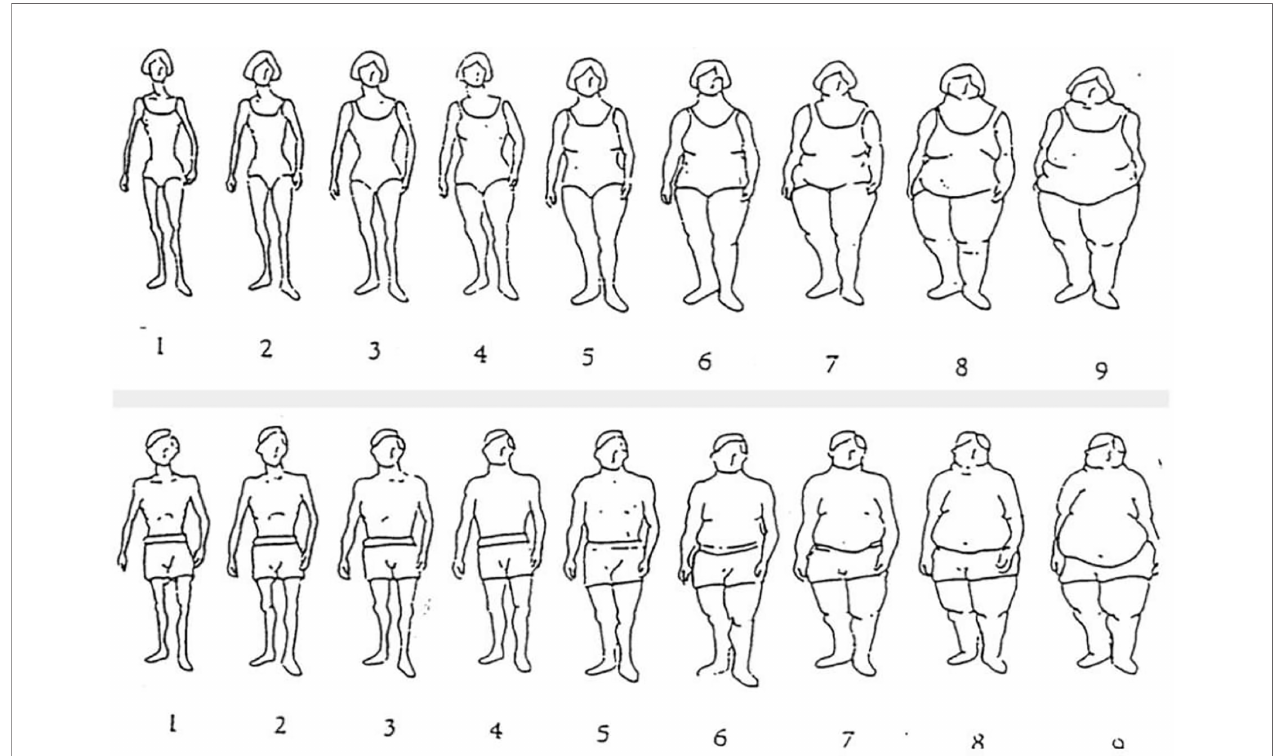
FIGURE 1 | Stunkard ’ s silhouette body drawings *Permission to use the fi gure is granted by the original